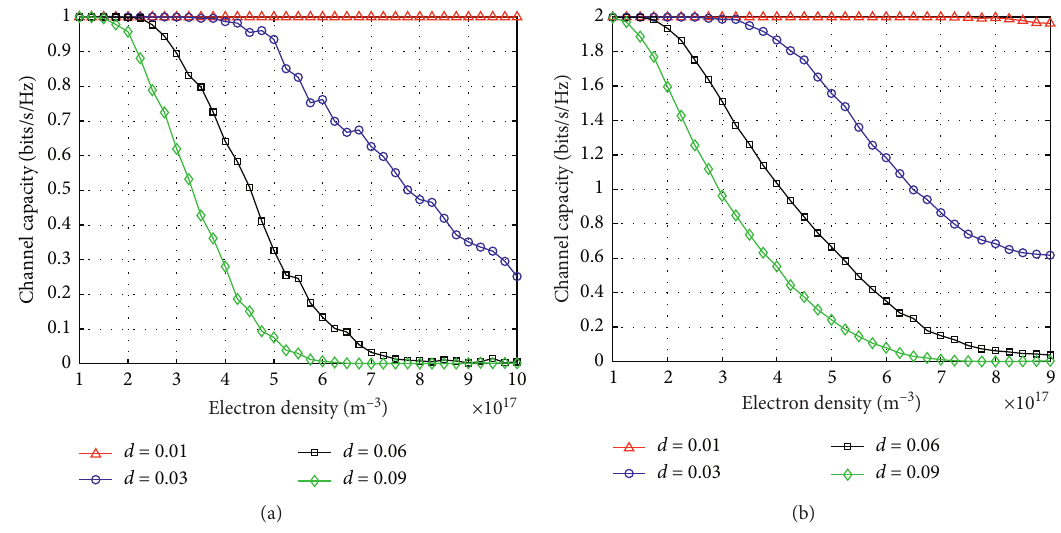
Figure 8: Influence of ( d ) on channel capacity. (a) BPSK, (b)